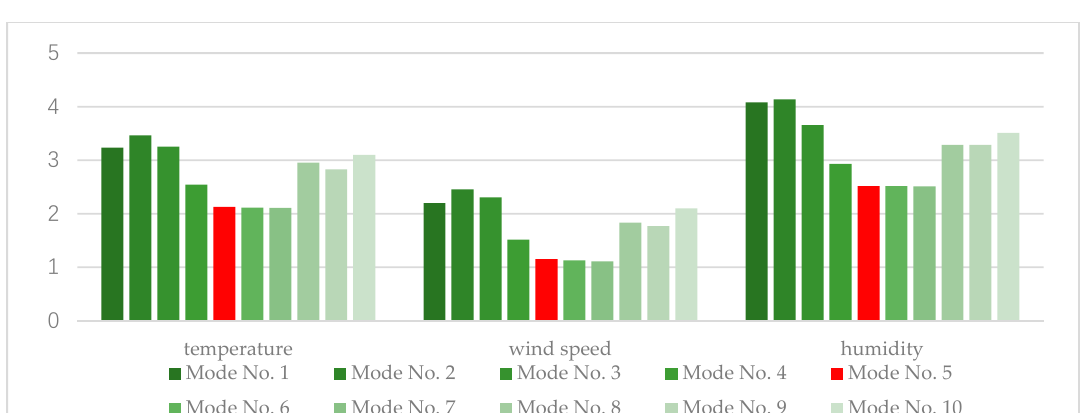
ff erent combination